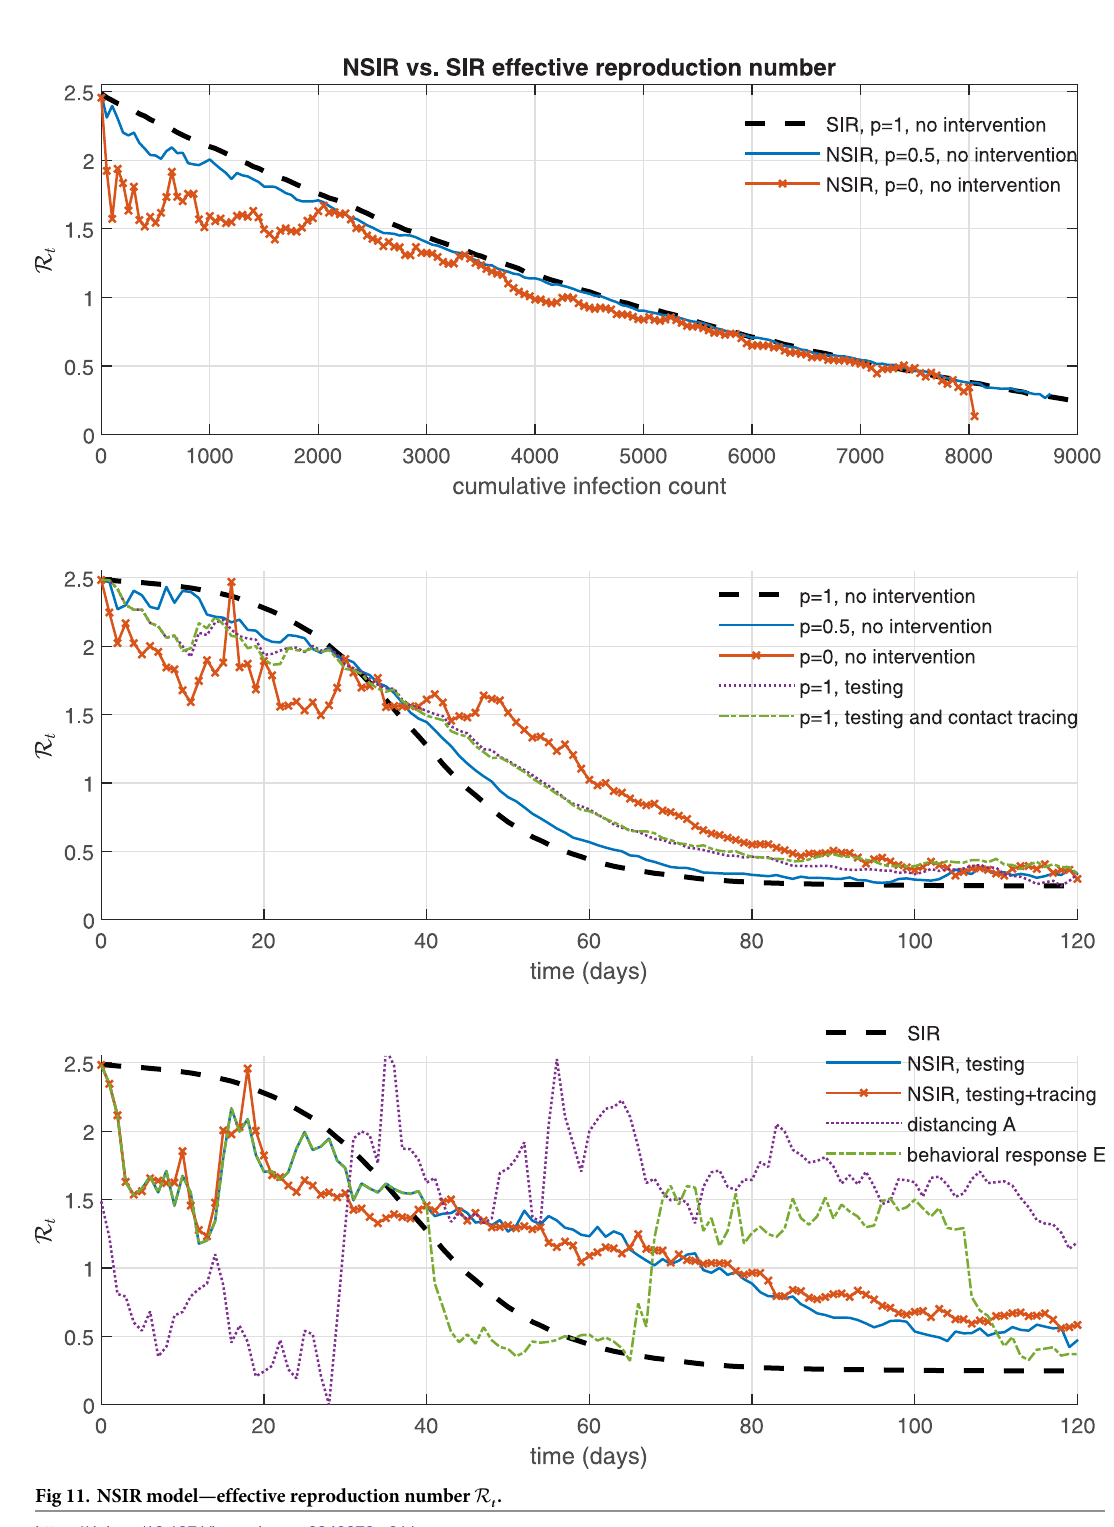
PLOS ONE | https://doi.org/10.1371/journal.pone.0240878 October 29,